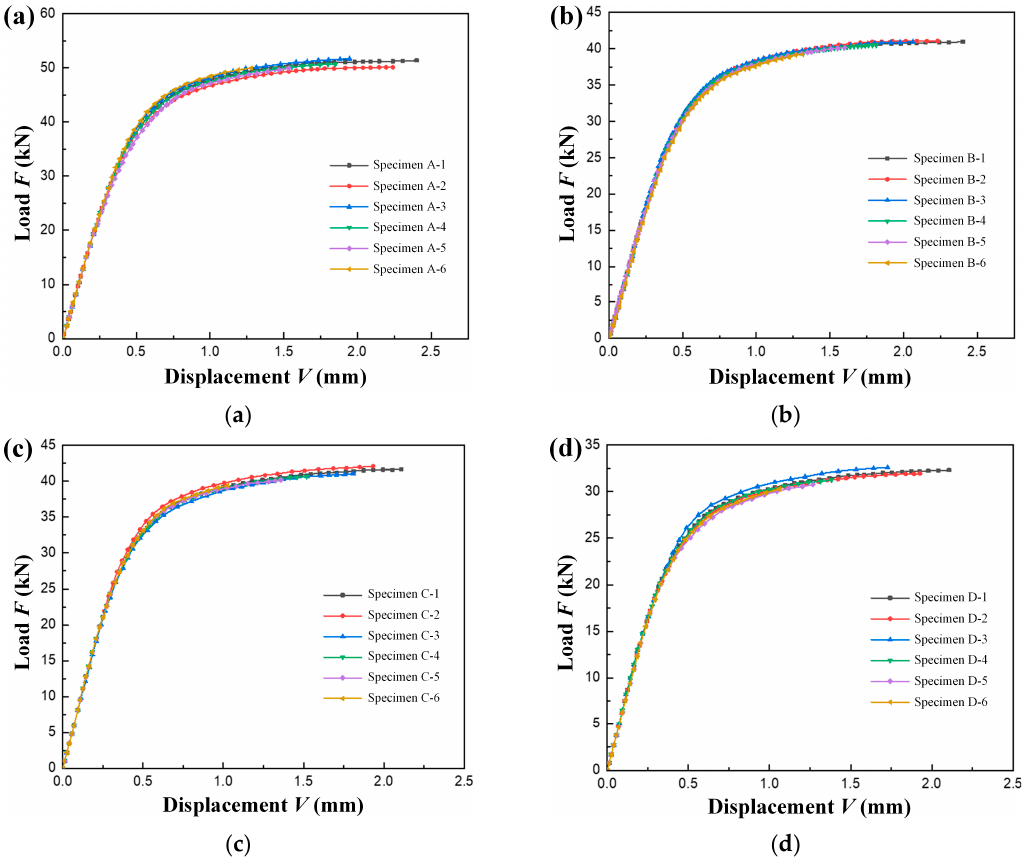
Figure 6. Load-displacement ( F - V ) curves of notch for each group of specimens: ( a ) SENB20 without side grooves; ( b ) SENB20 with side grooves; ( c ) SENB18 without side grooves; ( d ) SENB18 with side grooves.